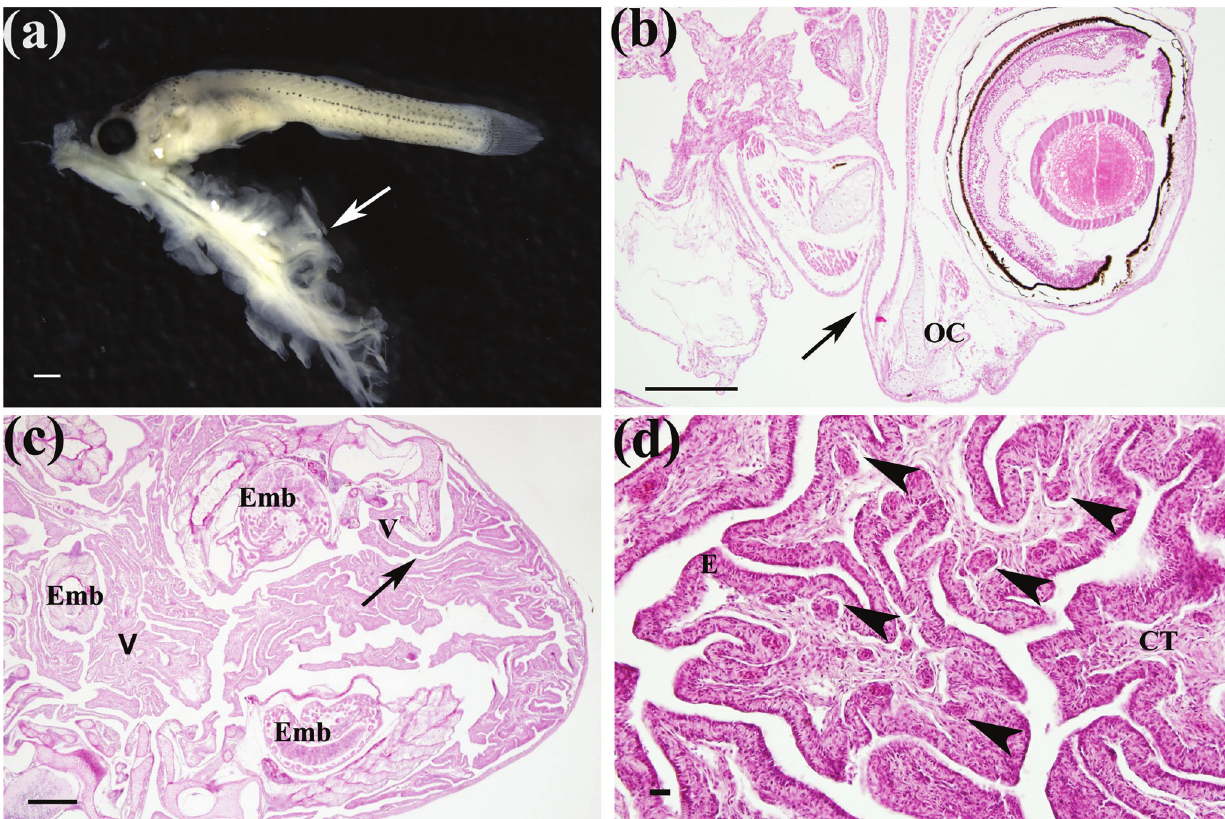
Fig. 2. Morphology of maternal-embryonic connections from the one-sided livebearer Jenynsia multidentata , based on macroscopic embryo and maternal-embryo structure (a); histological section of the embryo and maternal-embryonic (b); cystovarian with villus forming a maternal-embryonic connection (c); and blood vessels from the maternal-embryonic connection (d). Arrow: maternal-embryonic connection; Arrow-head: blood vessels; OC: oral cavity; Emb: embryo; V: villus; E: epithelium; CT: connective tissue. Scale bars of 0.5 mm (a), 200 m m (b, c) and 20 m m